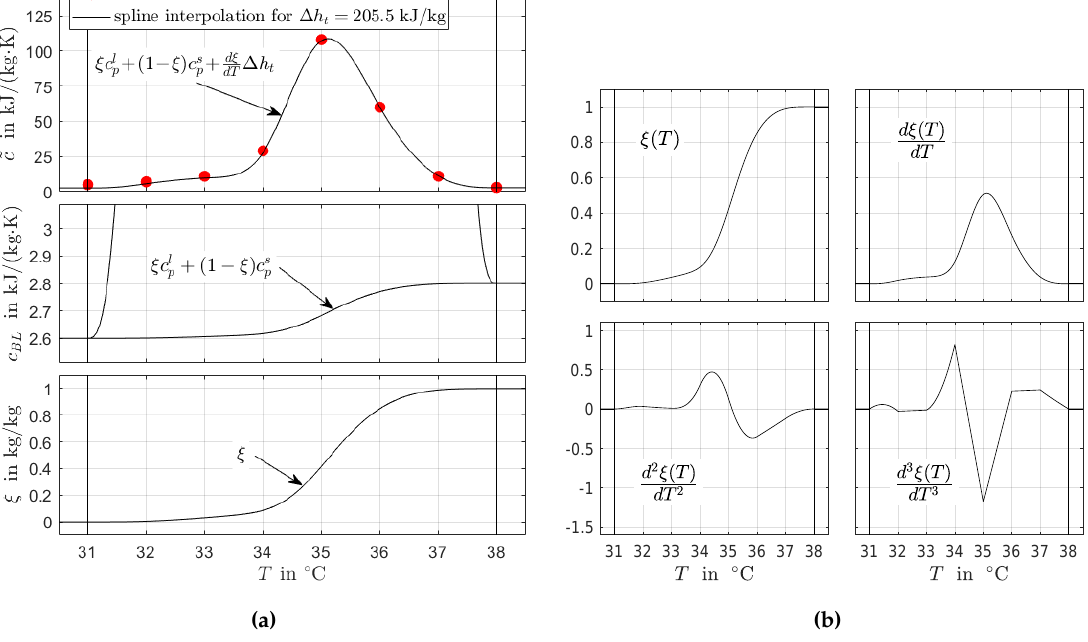
Figure 3. Spline interpolation, identified baseline and phase transition function for the data in Figure 1. ( a ) Results are given for the minimum arc length with ∆ h t = 205.5 kJ/kg (see Figure 2b). ( b ) The transition function ξ ( T ) is a C 3 smooth function, i.e., it is three times continuously differentiable on T ∈ [ − ∞ , ∞ ]